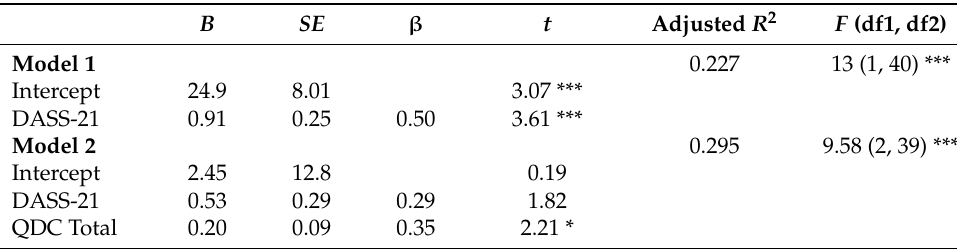
Table 4. Results of the hierarchical multiple linear regression (outcome variable: EDRC scale) considering the whole sample ( N = 50). B SE β t Adjusted R 2 F (df1, df2) Model 1 0.227 13 (1, 40) ***